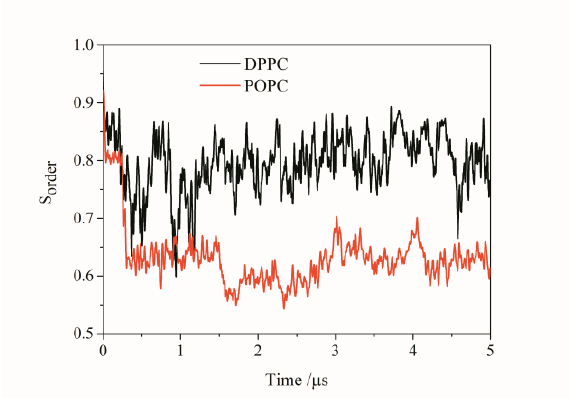
Figure 4. The order parameter of the alpha C atoms of the largest Aβ channel as a function of time on a two lipids membrane: POPC and DPPC.